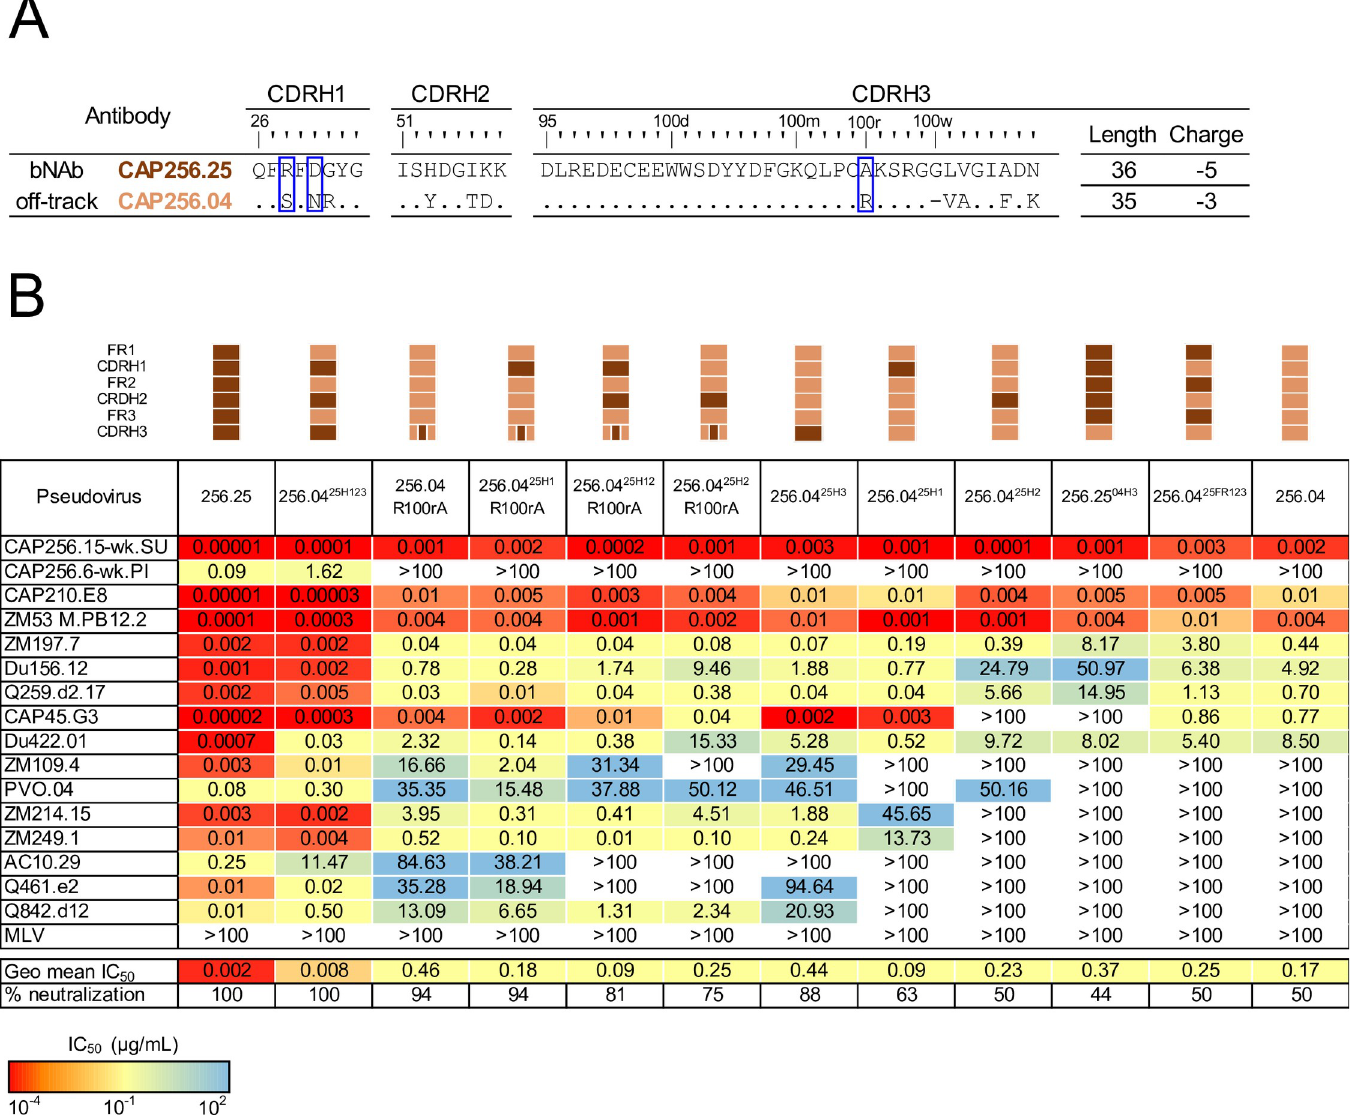
(B) Neutralization data using mutants and chimeras (indicated schematically above the table) between CAP256.25 and CAP256.04, with neutralization potency shown by color, as indicated in the key. Neutralization data represents the arithmetic mean titers (IC 50 , μ g/mL) from at least two